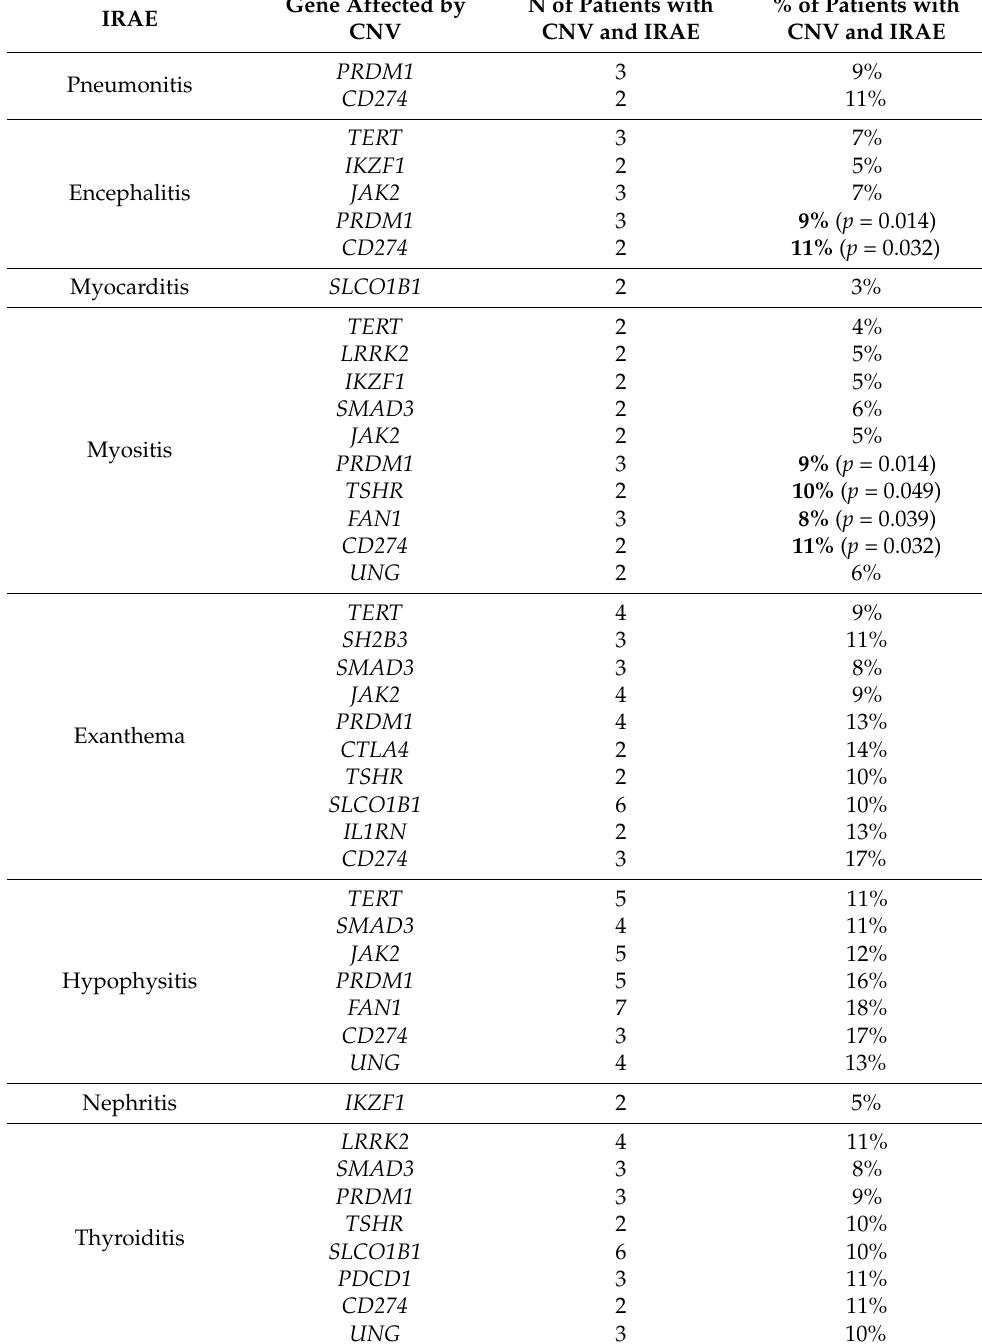
Table 8. Genes affected by CNVs in general associated with IRAE. Note that we only list genes with observed incidence of IRAE above the respective cohort average and concerning at least two